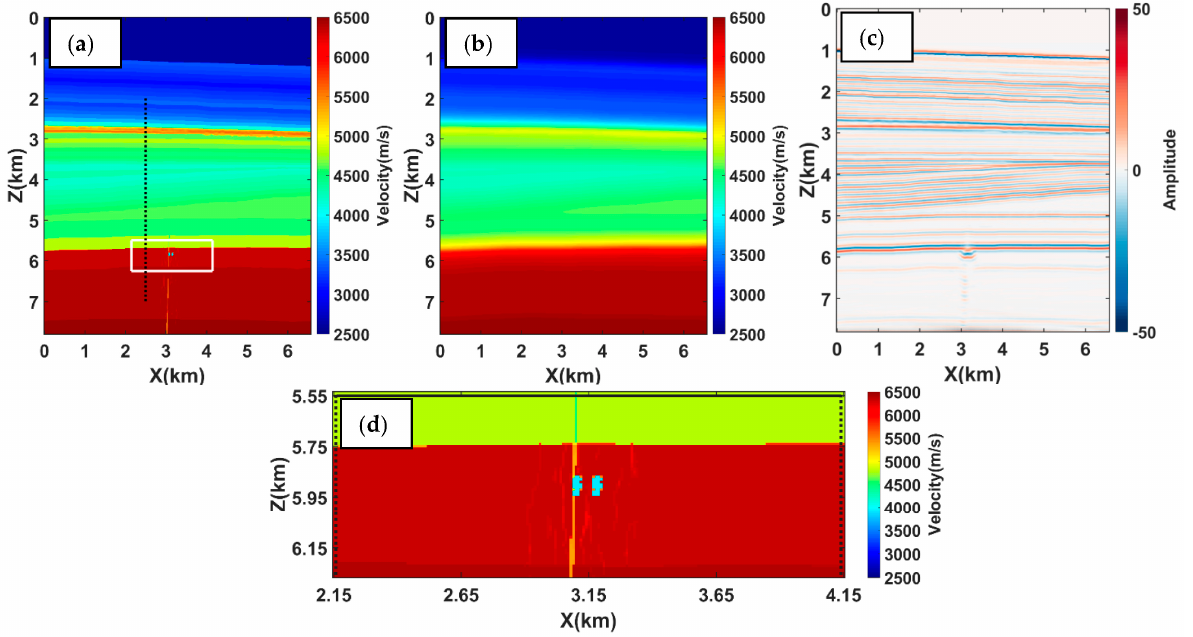
Figure 7. The 2D profile of the Benchmark model ( a ), the initial model for migration ( b ), the RTM imaging ( c ), and the target zone of the true model ( d ). The black solid line in subfigure ( d ) indicates the setting location of virtual receivers x vr in standard Marchenko local FWI. The black dashed lines indicate the setting location of virtual receivers x vsp vr in VSP-driven Marchenko local FWI. The black dashed line is the well location. And the white color rectangle is the target region.